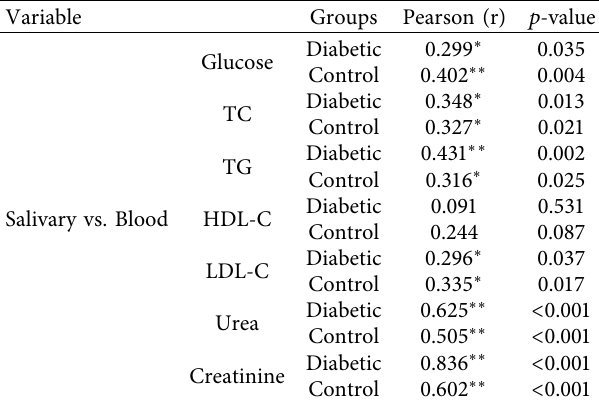
Table 4: Correlation between salivary and blood biochemical